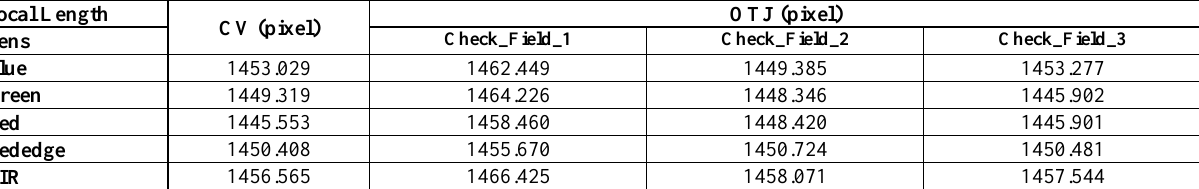
Table 4: Calibrated focal length using the CV method and OTJ automatic calibration.